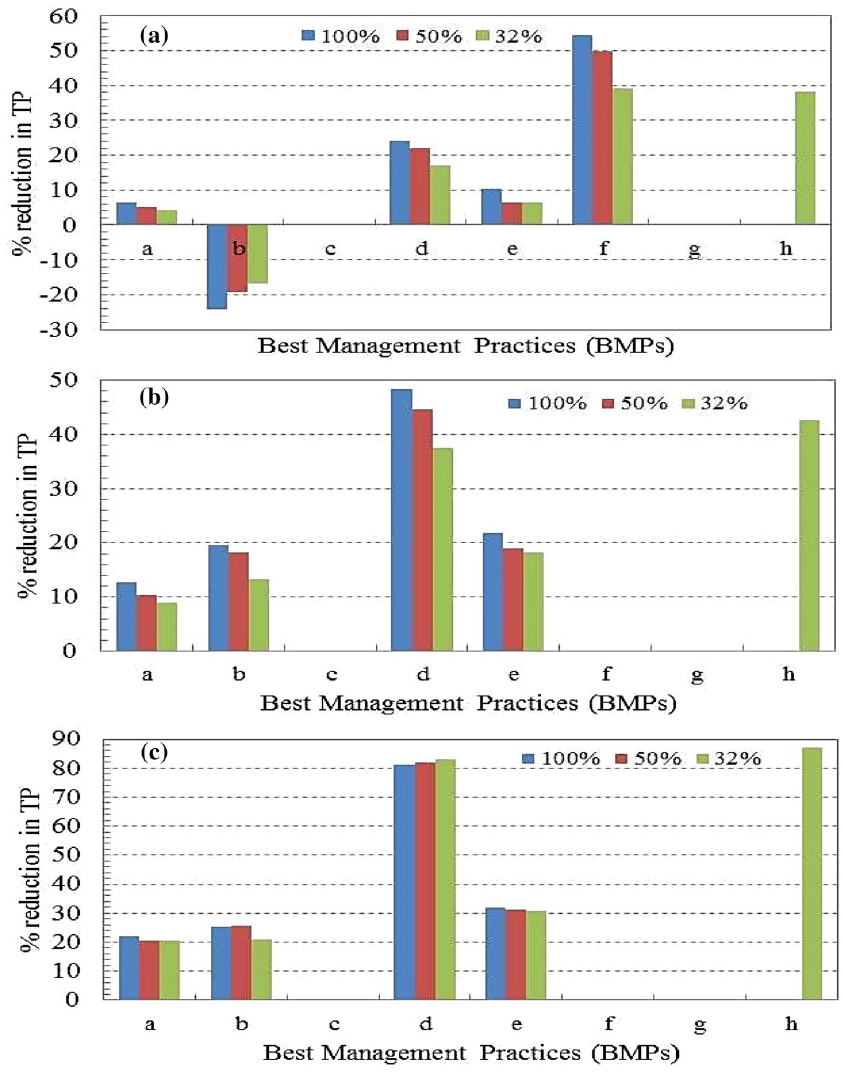
Fig. 10 TP declination in per- cent for various percentage of varied-crop region treated a at watershed level, b at sub-water- shed level and c at HRS level